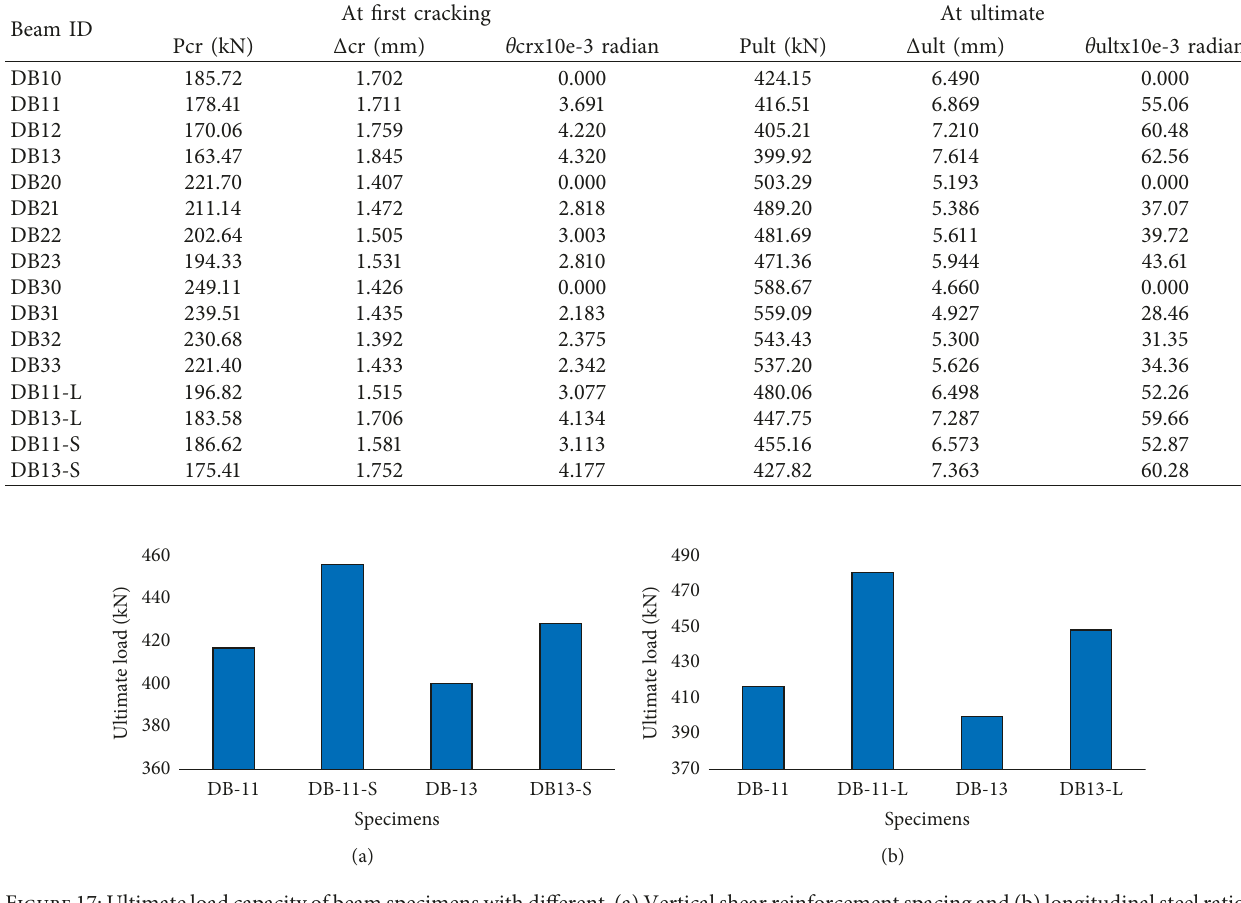
Figure 17: Ultimate load capacity of beam specimens with different. (a) Vertical shear reinforcement spacing and (b) longitudinal steel